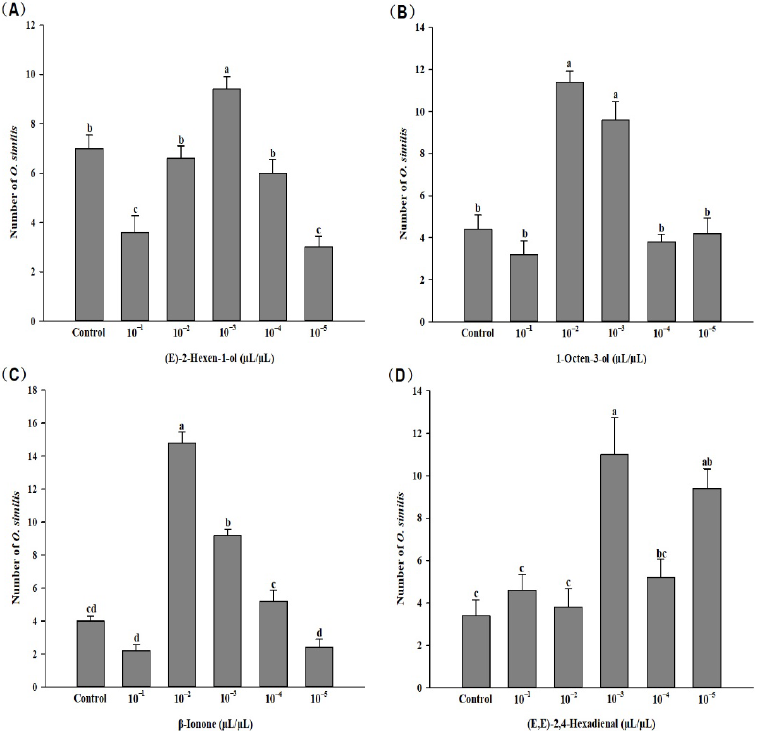
Figure 4. Response of female O. similis adults to volatile compounds of different concentrations. Letters on bars indicate significant differences (Tukey’s test, p < 0.05).